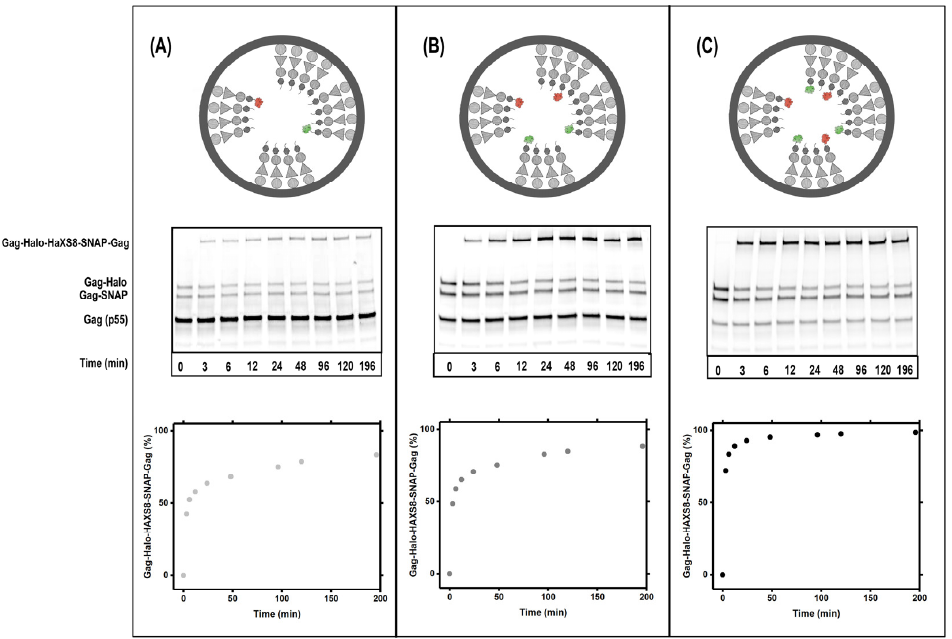
Figure 2. Dynamics detected by kinetic biochemical assay. HIV Gag VLPs were assembled from HEK293 cells by expressing: ( A ) Top shows a model of a Gag VLP with 80% Gag, 10% Gag-SNAP and 10% Gag-Halo. Both Halo and SNAP are fused to Gag after the p6 domain as further explained in text. HaXS8 is applied to the VLP solution at time zero and VLP fractions are harvested according to the displayed time. The ratio of the hetero-dimer formation in the presence of HaXS8 as a function of time is quantified from the western blots. ( B ) Similar to ( A ) except with 60% Gag, 20% Gag-SNAP and 20% Gag-Halo. ( C ) similar to A and B except with 20% Gag, 40% Gag-SNAP and 40%